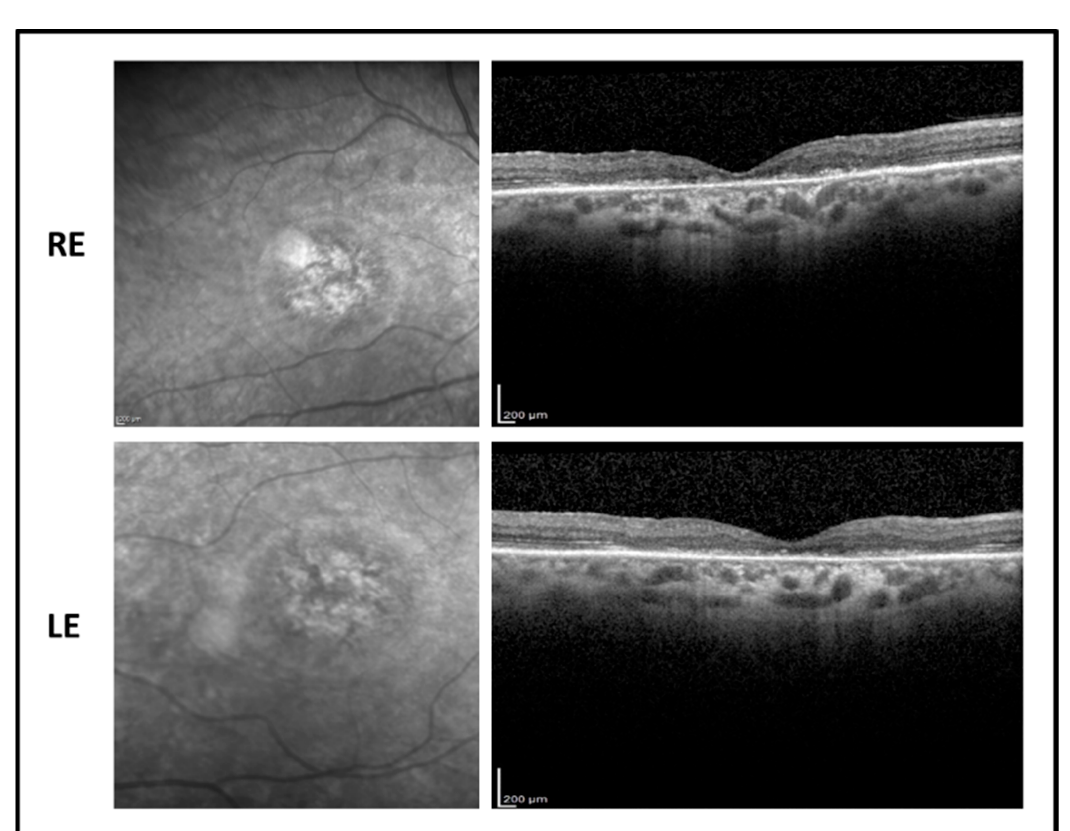
Figure 5. Infrared ( left side ) and OCT ( right side ) images of the right eye (RE) and left eye (LE) of patient 4 showing a marked foveal thinning with advanced photo-receptor layer disruption. Scale bar shown in the upper left panel applies also to lower left panel.